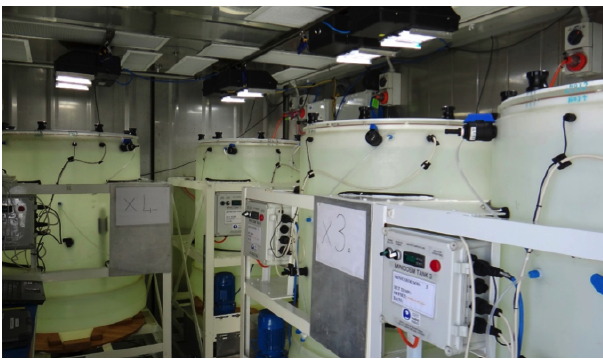
Figure 1. Minicosm tanks filled with seawater in a temperature- controlled shipping